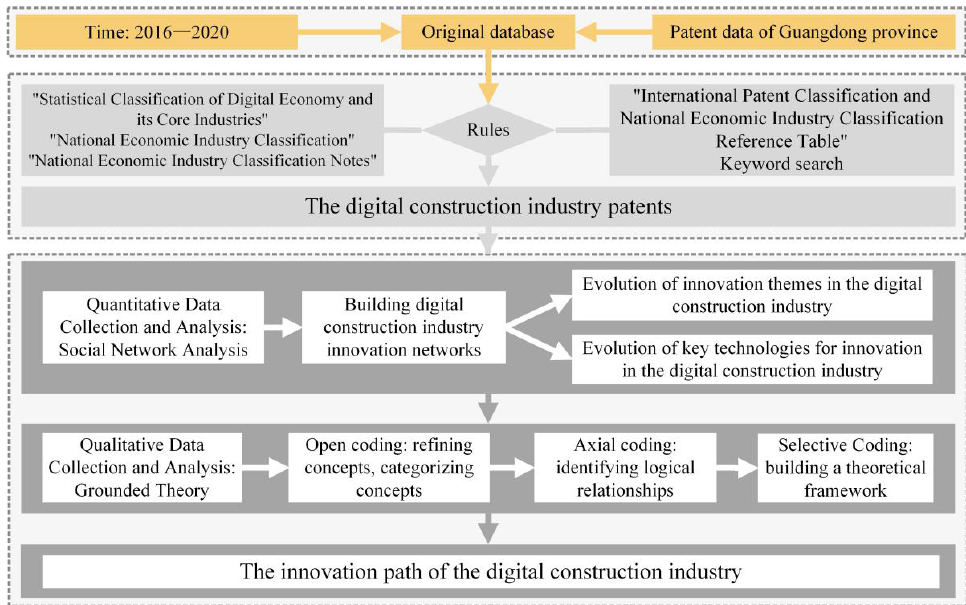
Figure 2. Research steps.